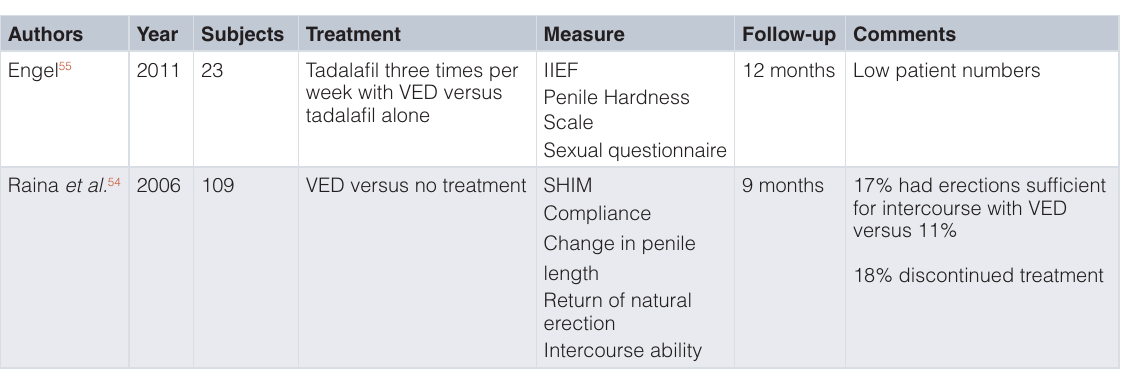
Table 3. Randomised trials of vacuum erection